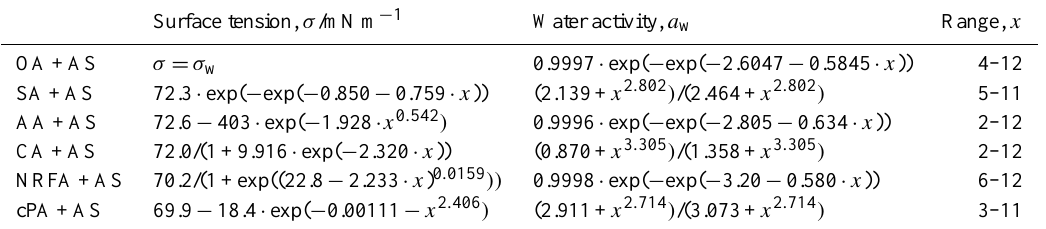
Table 3. Fitted functions of surface tension and water activity as a function of growth factor ( x =GF) for the studied 50:50 mixtures containing ammonium sulphate (abbreviations are explained in Table